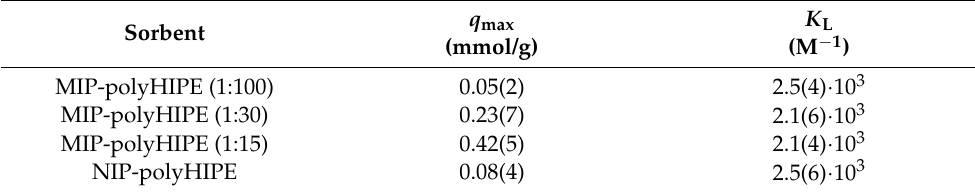
Table 1. Parameters of the Langmuir isotherms for MIP-polyHIPEs at different ratios of IRB:functional monomer (1:100; 1:30; and 1:15) and NIP-polyHIPE (average values obtained from five isotherms for each material. Numbers in parentheses are the standard deviation on the last digit). Experimental conditions: 15 mg sorbent in 5 mL of 0.1 M acetate buffer at pH 5 containing increasing amounts of IRB (from 8 µ M to 8 mM). T = 25 ◦